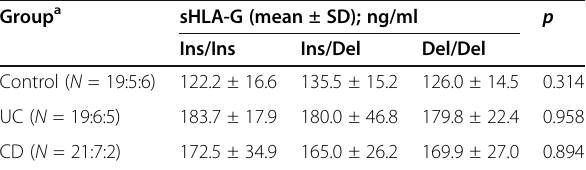
Table 6 Serum level of sHLA-G antigens in inflammatory bowel disease (ulcerative colitis and Crohn ’ s disease) patients and controls distributed according to HLA-G 14-bp insertion/ deletion genotypes Group a sHLA-G (mean ± SD); ng/ml p